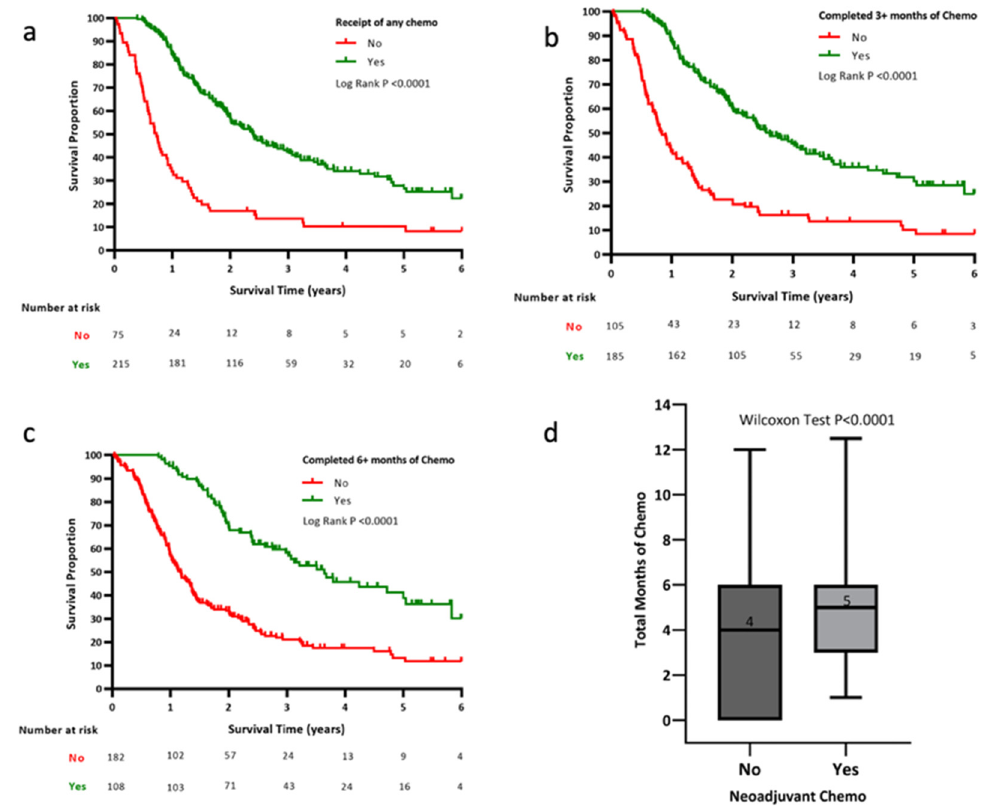
Figure 3. Receipt of systemic therapy is strongly associated with improved OS. Kaplan–Meier OS for patients who received any CHT ( a ), 3+ total months of CHT ( b ), and 6+ total months of CHT ( c ). Log-rank p -values are displayed. ( d ) A box plot comparison of the total months of CHT in those who received neoCHT versus those who did not.